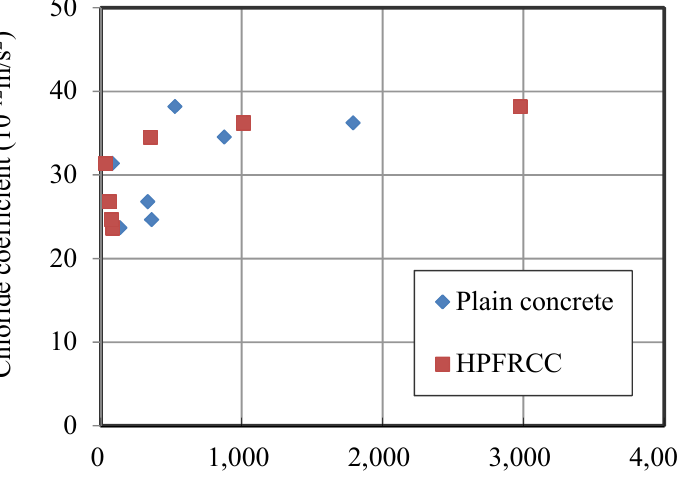
Figure 12. Chloride diffusion coefficients with respect to the residual specific crack